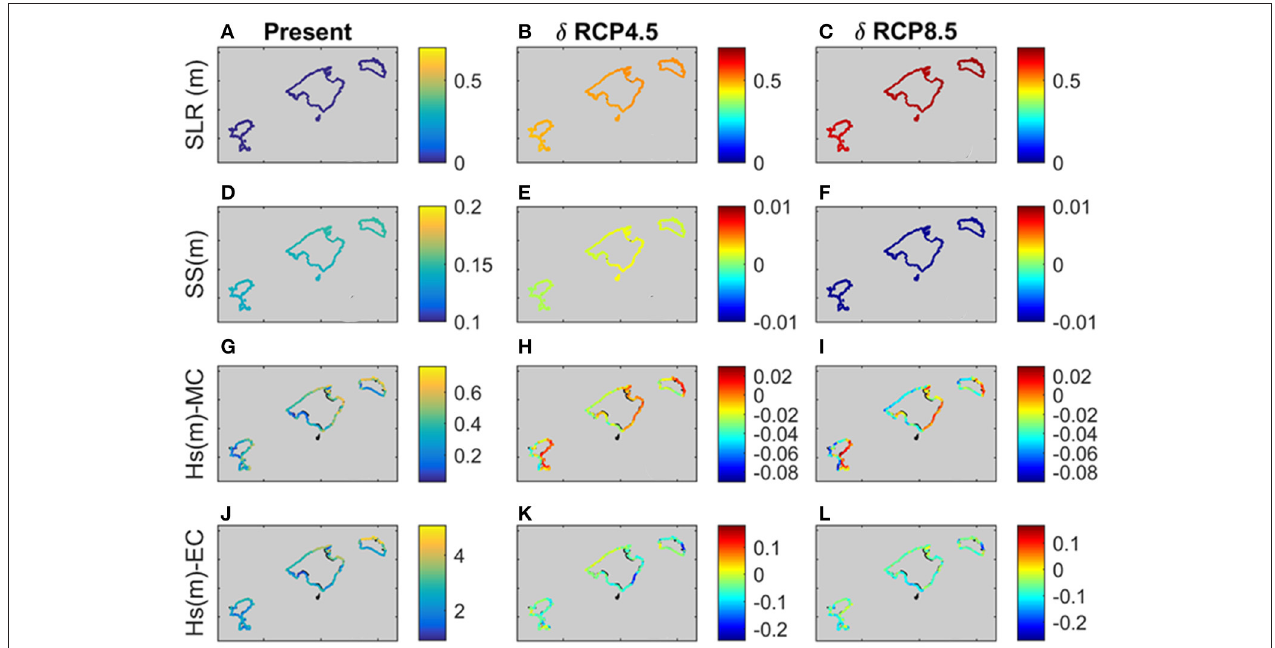
FIGURE 7 | Changes in Sea level (A–C) , in storm surge (D–F) , Hs mean under mean conditions (G–I) and under extreme conditions (J–L) . RCP 4.5 scenario (middle column) and RCP 8.5 scenario (right column) at the end of the century (2080–2100), respect to the current conditions (1979–2013; left column). By definition, the mean sea level in present climate is set to zero. Units in